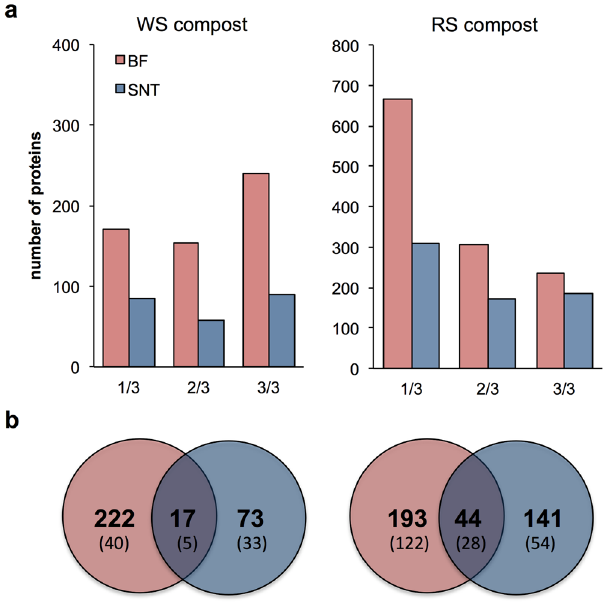
Figure 2. Characterization of the metasecretomes of wheat straw (WS) and rice straw (RS) compost derived communities. ( a ) The number of proteins detected in all three (3/3), two (2/3) or only one (1/3) biological replicate (x-axis) in the biotin-labelled (BF) and supernatant (SNT) fractions. ( b ) Venn plots of unique and shared proteins present in all biological replicates in different designated fractions of WS and RS metasecretomes. In the brackets, numbers of extracellular proteins carrying predicted signal peptide and no transmembrane region targeted by biotinylation or collection of supernatant are